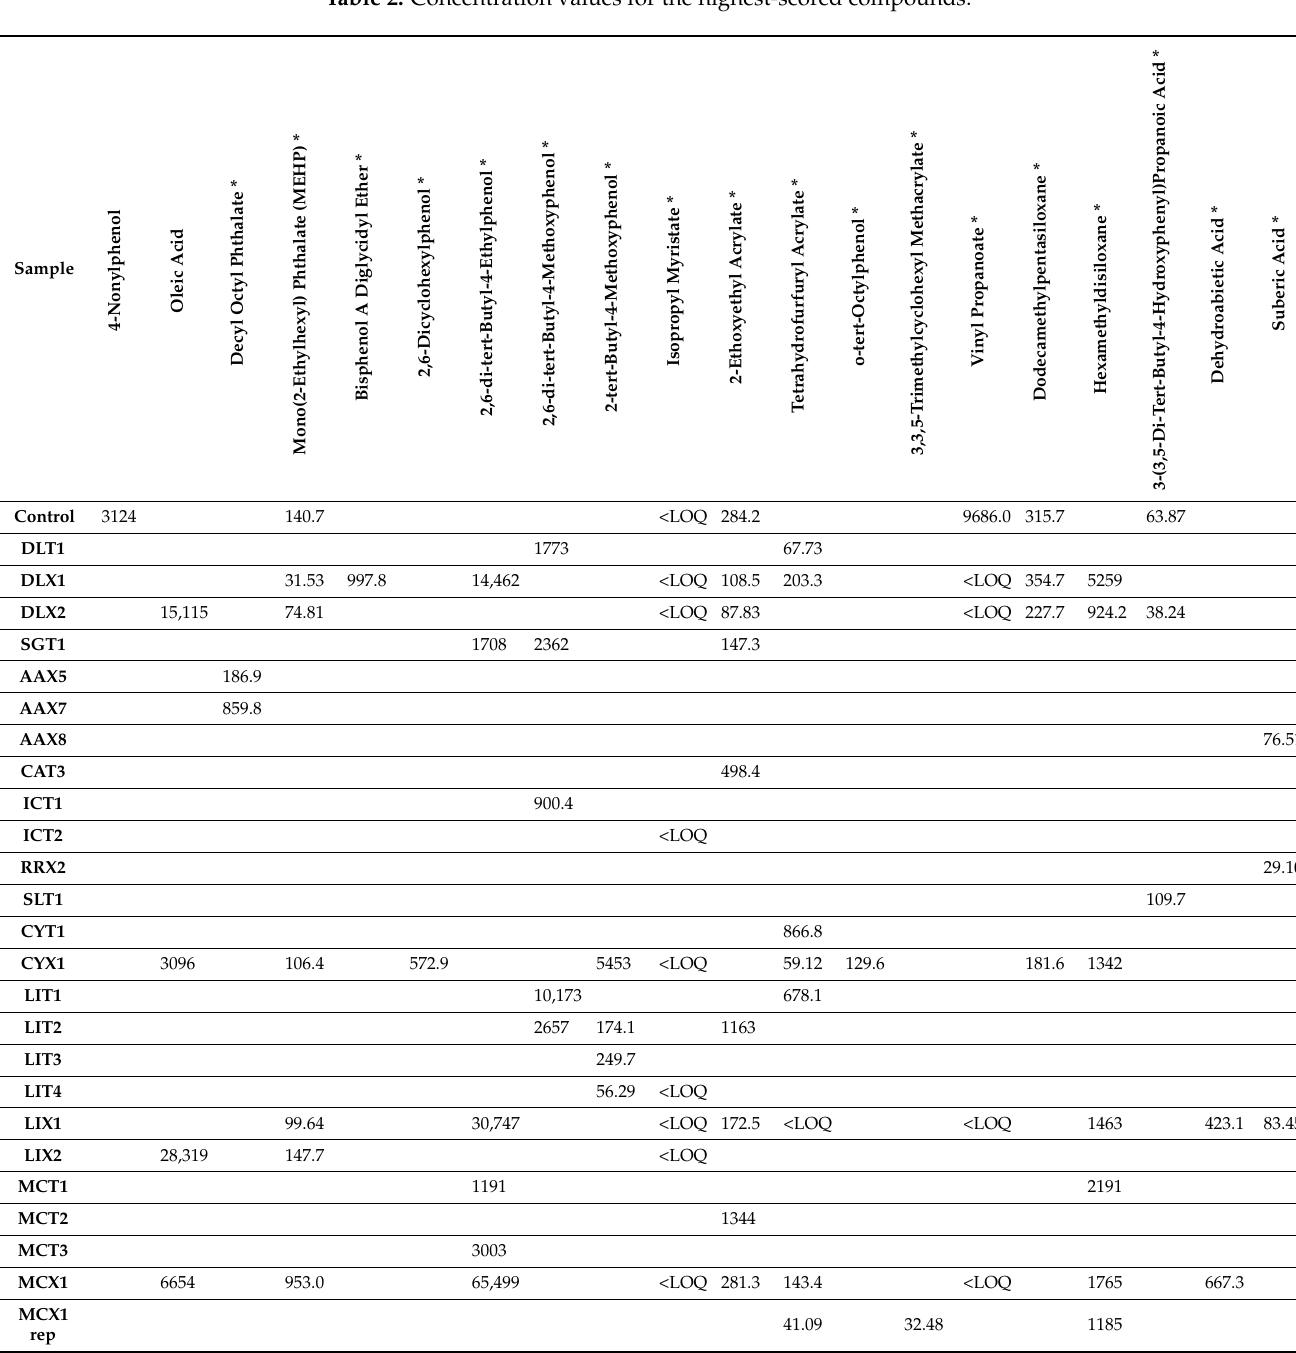
Table 2. Concentration values for the highest-scored